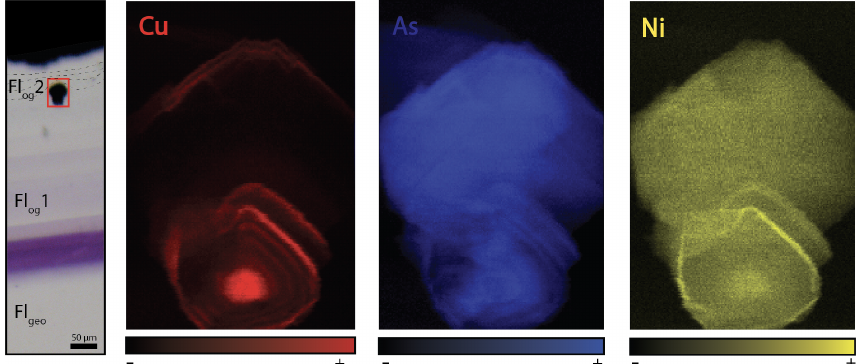
Figure 7. Copper, arsenic and nickel distribution maps of a pyrite included in Fl og 2. Map dimensions are 52µm ×